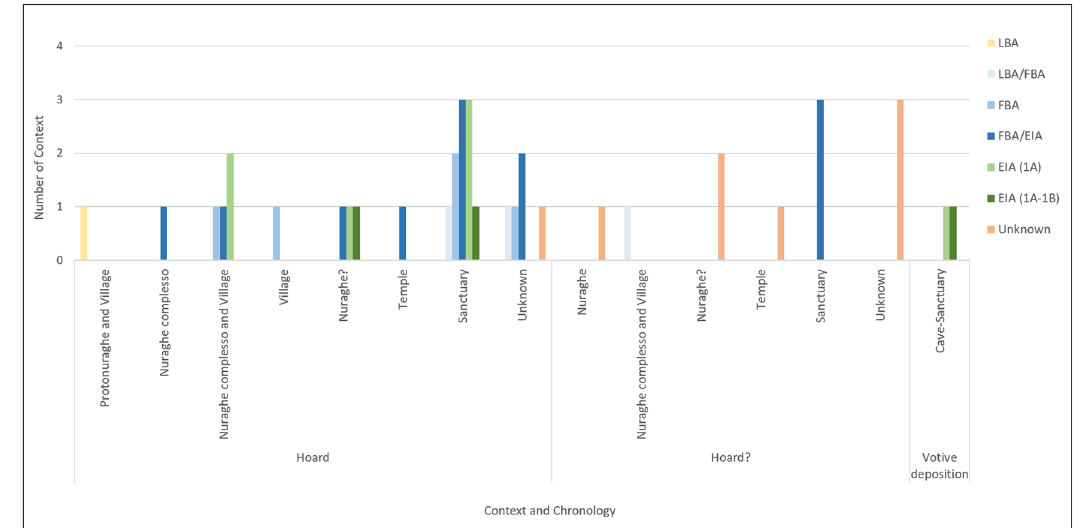
Figure 6: Foreign artefacts and archaeological contexts. The plot shows the number and type of contexts in which the majority of foreign Bronze and Iron Age metalworks were discovered in Sardinia. The graph includes oxhide ingots, Iberic metalworks, and Etruscan fi bulae ( Fundoni, 2013; Lo Schiavo, 2018a; Tronchetti, 1988; Plot: Valentina Matta © )